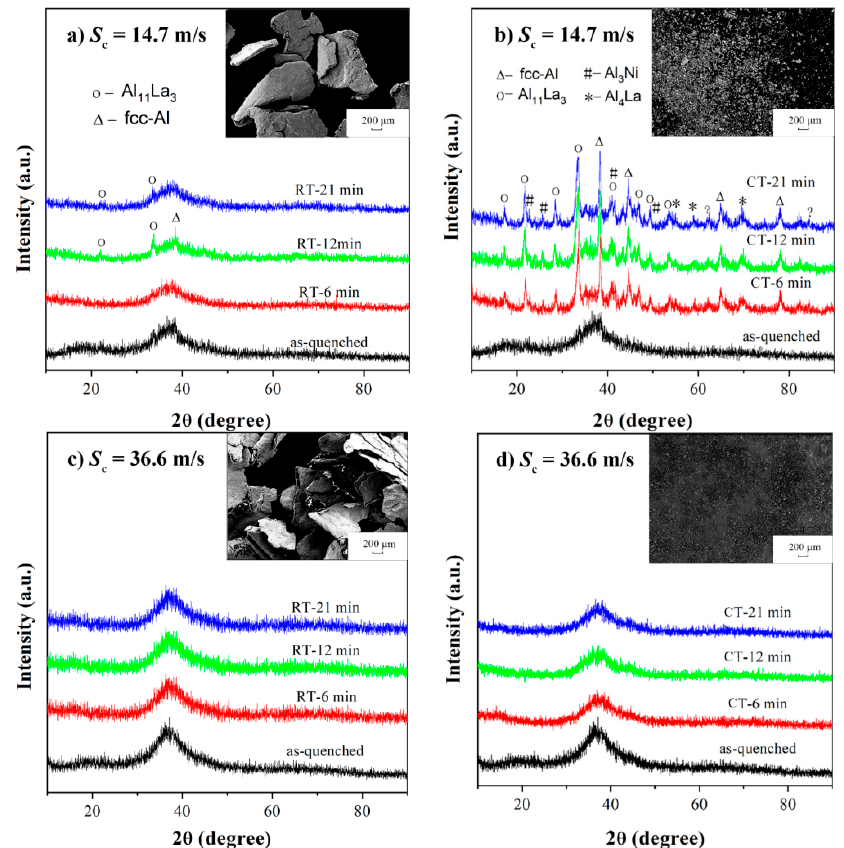
Figure 1. The XRD patterns of milled Al 86 Ni 9 La 5 samples with different S c and milling temperatures: ( a ) RT, S c = 14.7 m/s; ( b ) CT, S c = 14.7 m/s; ( c ) RT, S c = 36.6 m/s; ( d ) CT, S c = 36.6 m/s. The inset of each pattern is the SEM image of the corresponding samples after 21 min of milling.